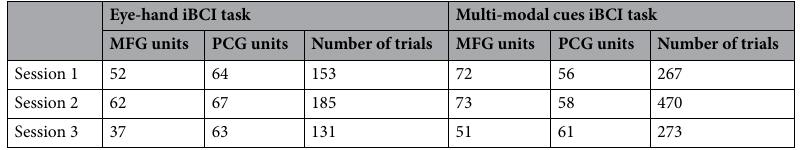
Table 2. Summary data for single unit and trial numbers during iBCI tasks. MFG, middle frontal gyrus; PCG, precentral gyrus; iBCI, intracortical Brain Computer